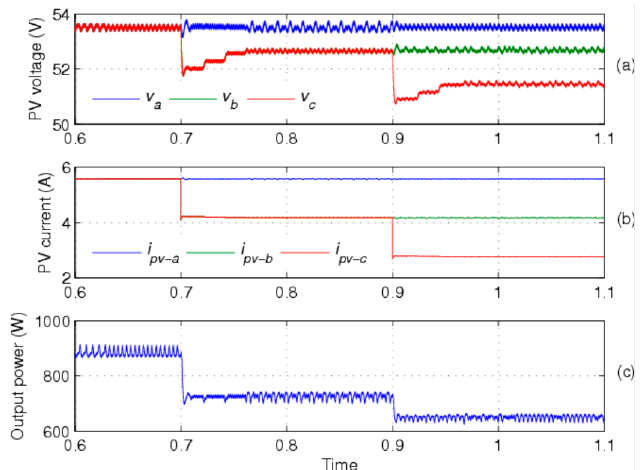
Figure 7. Results of the proposed high-frequency multi-port converter with three PV modules.